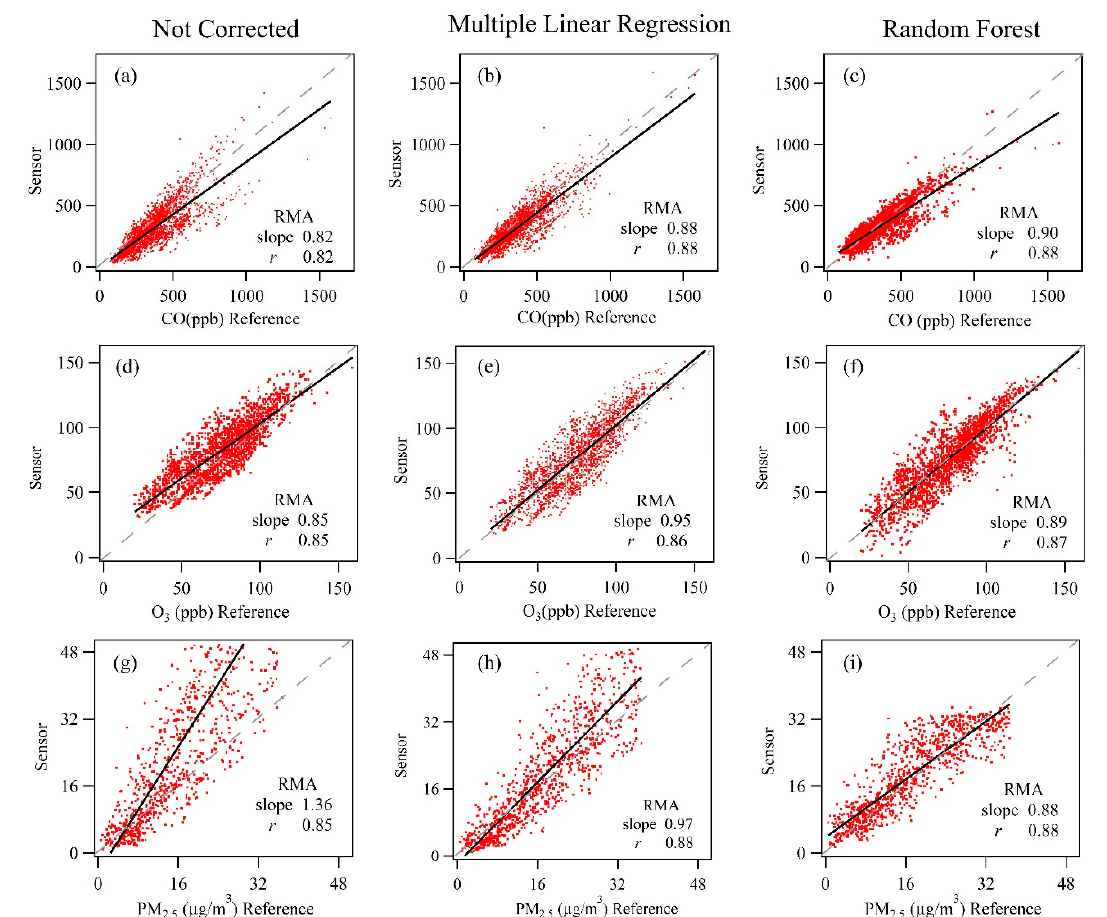
Figure 8. Comparison of scatterplots between the reference and sensor data for the test dataset of the original out-of-sensor data ( a , d , g ), after correction using multiple linear regression ( b , e , h ), and after correction using a random forest model ( c , f , i ).